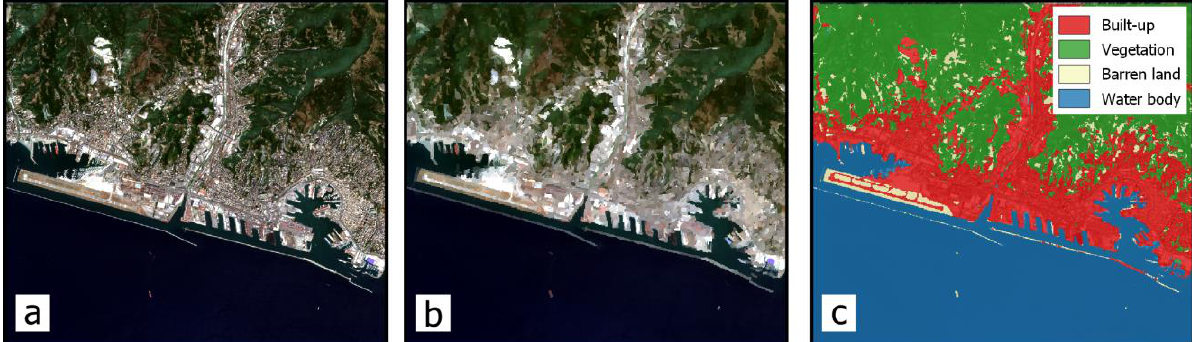
Figure 7 . Genoa natural color composite (a), segmented natural color composite (b), and classification result (c).